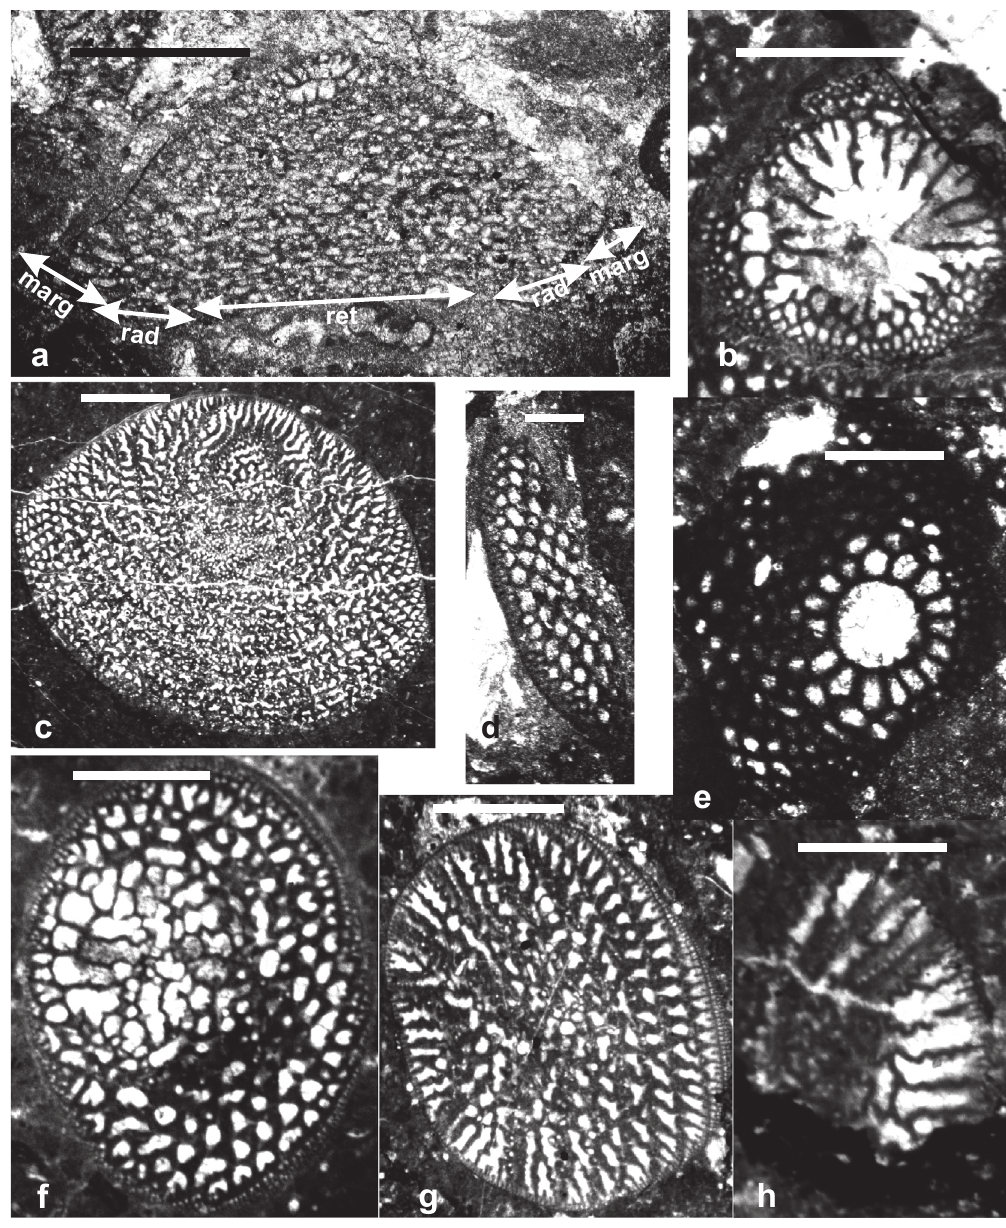
apparatus divided into a protoconch and deuteroconch but a not completely divided sub- embryonic zone, as in Praeorbitolina . This latter evolved in turn into forms in which the deuteroconch and sub-embryonic zone are more or less of equal size, as in Mesorbitolina (Plate 1, d). In Conicorbitolina (Plate 3, f) the marginal zone became extensively divided by vertical and horizontal partitions, while in Orbitolina the deuteroconch is highly subdivided and of much greater thickness than the sub-embryonic zone (see Figs 4, 5; [6, 28, 31, 57, 66, 67]). In transverse section, the chambers are seen divided into a marginal zone, with sub- epidermal partitions, and a central zone with radial partitions (Plate 1, a; Figs 8.1–8.2, 9). The chamber passages are formed in the radial part of the central zone of each chamber layer (Figs 8.1–8.2, 9h), where each chamber passage is subdivided by vertical main partitions, which are prolongations of the vertical main partitions of the marginal zone (Figs 9a–f, h). The radial partitions (Fig. 9f) in advanced orbitolinids (e.g. Mesorbitolina, Orbitolina ) thicken away from the periphery and anastomose in the central area, producing an irregular reticular network (Plate 1, c, f–h; Figs 9g, i–j; Fig. 10b). In cross-section, the chamber passages can be triangular (Figs 9c, 10a), rectangular (Fig. 10c) or oval, or can show a gradation between shapes (Fig. 9e) [28]. In the radial zone of Orbitolina, the stolons are arranged in radial rows alternating from one chamber to the next one (see [1]). Their alternating position would have obliged the protoplasm to flow in an oblique direction [66]. In the annular radial zone of